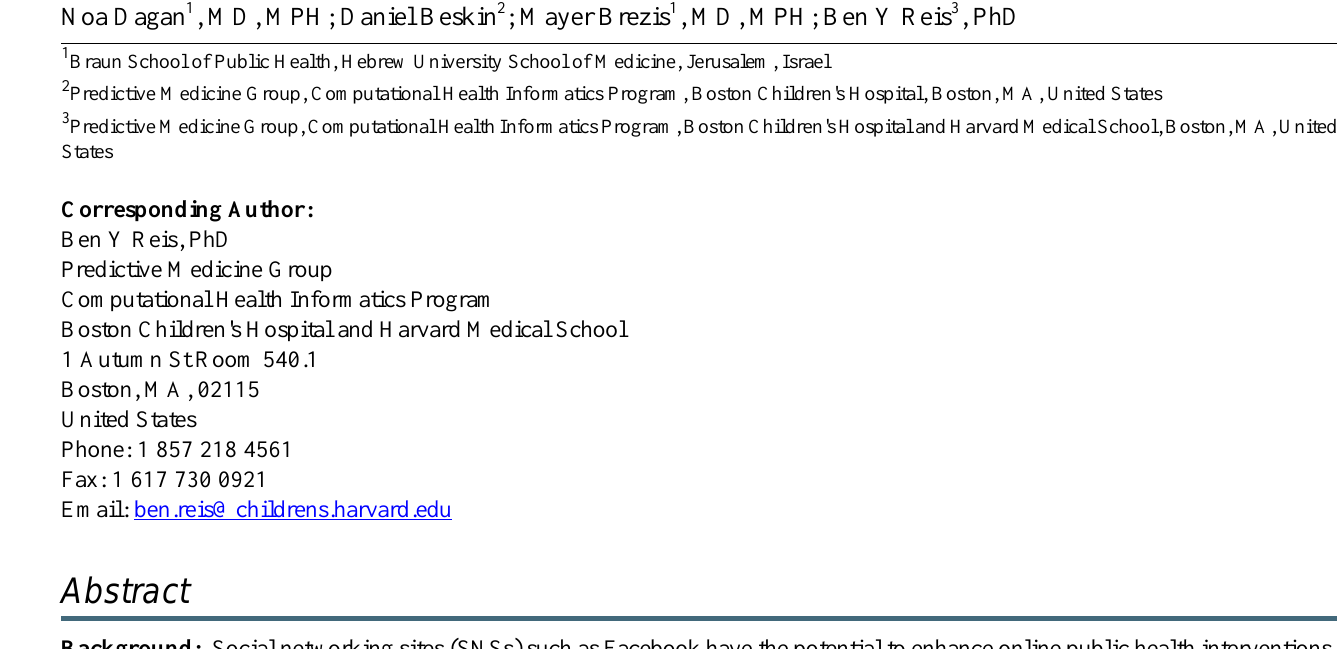
nutrition requirements; obesity; public health; social networking